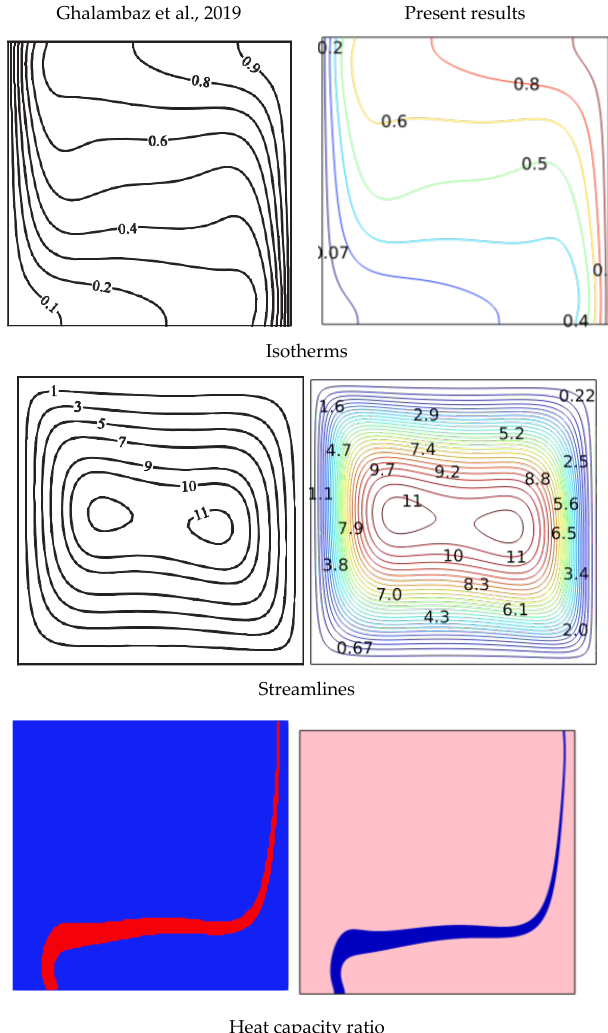
Figure 2. Comparison of isotherms, streamlines and heat capacity ratio with those of Ghalambaz et al. [12].